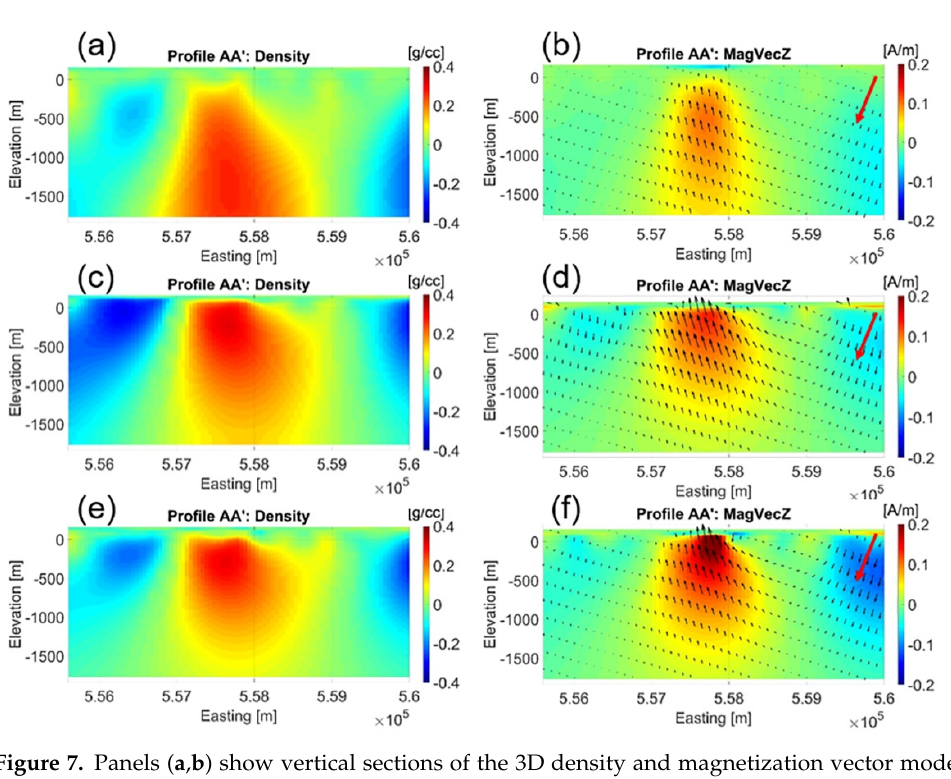
Figure 7. Panels ( a , b ) show vertical sections of the 3D density and magnetization vector models obtained from standalone inversions, respectively. Panels ( c , d ) show vertical sections of the 3D density and magnetization vector models obtained from joint inversion with Gramian constraints, respectively. Panels ( e , f ) show vertical sections of the 3D density and magnetizations vector models obtained from joint inversion with joint focusing constraint, respectively. Panels ( b , d , f ) show the vertical component of magnetization vector in color; the full magnetization vector is shown by the black arrows, and the inducing field direction is shown by the red